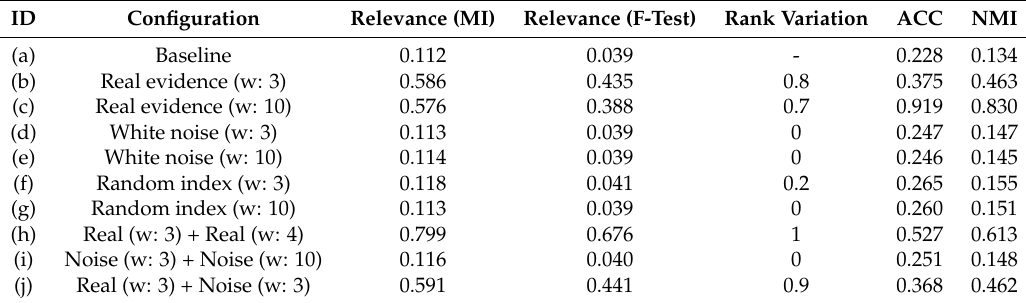
Table 2. The CIFAR-10 dataset results: during the CIFAR experiments, real corresponding evidence represent supersets of the original dataset labels. The Real corresponding evidence of width 3 represents a three-group aggregation into namely Vehicles, Pets, and Wild Animals. Width 4 expands the Pets category into two more sets, while width 10 represents the labelset of CIFAR-10.